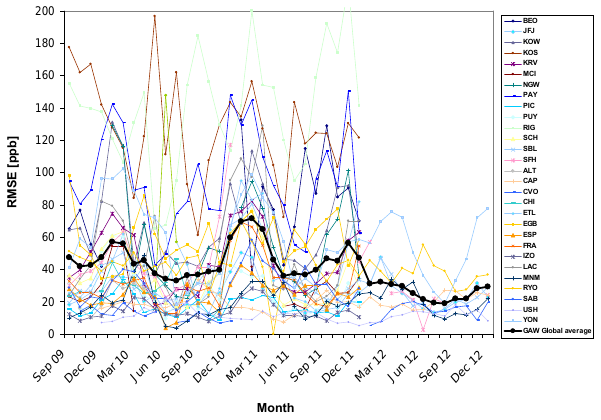
Figure 11. Root mean square error (RMSE) in ppb derived from the evaluation of the MACC_osuite with GAW CO surface obser- vations over the period September 2009 to December 2012 (black line: global average of 29 GAW stations multi-coloured lines: indi- vidual station results; see legend to the right).